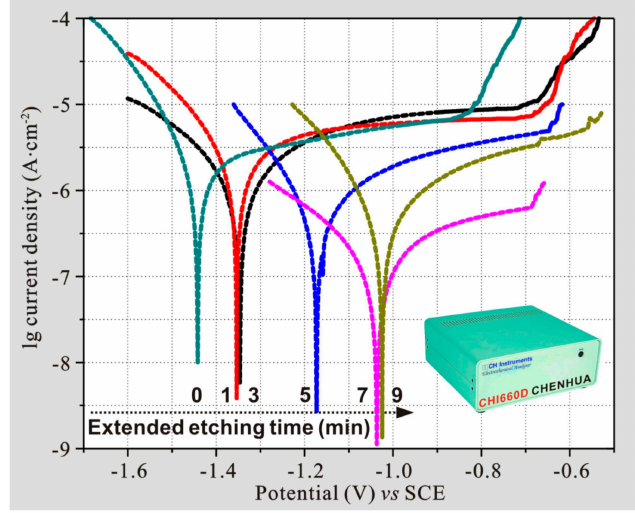
Figure 10. Polarization curves of modified 7075 aluminum alloys with various etching times. The insert shows the electrochemical workstation used to test the polarization